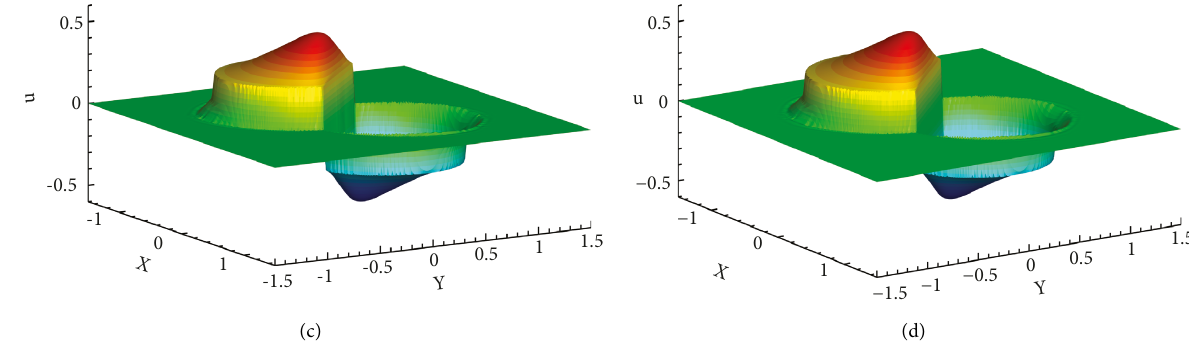
Figure 12: Example 9. 2D strong parabolic equation. T � 0.5. CRUS-WENO scheme (a, c); WENO-JS scheme (b, d). 200 × 200 grid error Figure 7 that the maximum error of the CRUS-WENO scheme is smaller than that of the WENO-JS scheme.